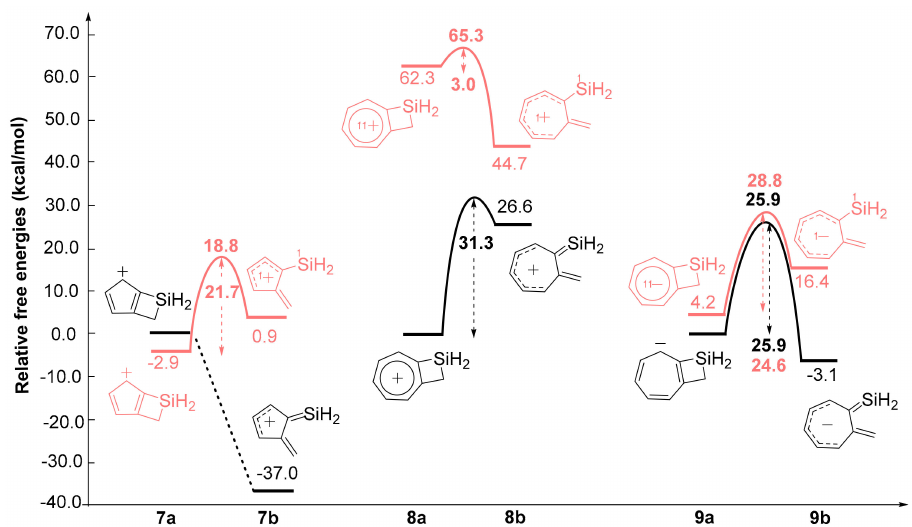
Figure 9. Free energy changes in 5- and 7-membered annulenyl cations and anions fused with SCB rings upon ring-openings at (U)B3LYP/6-311G(d,p) level. Compound 7a ( S 0 ) is not a minimum in the S 0 state. The black energy levels represent S 0 and those of red indicate T 1 state and energies for transition states are given in